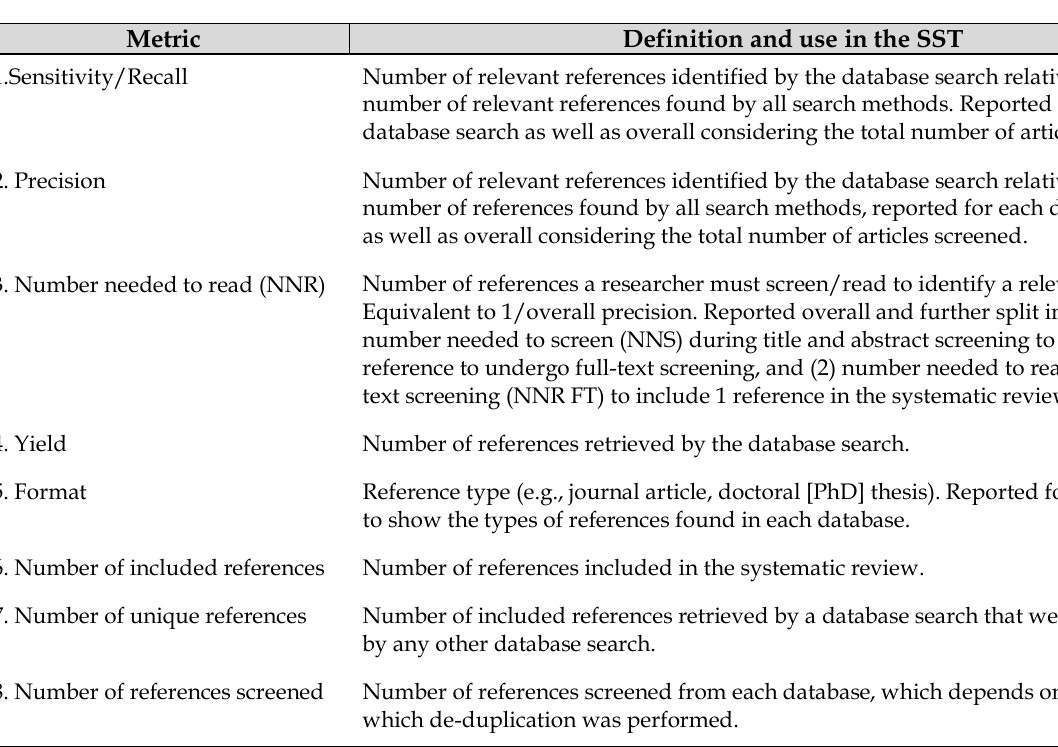
Table 2 Metrics used in the search summary table